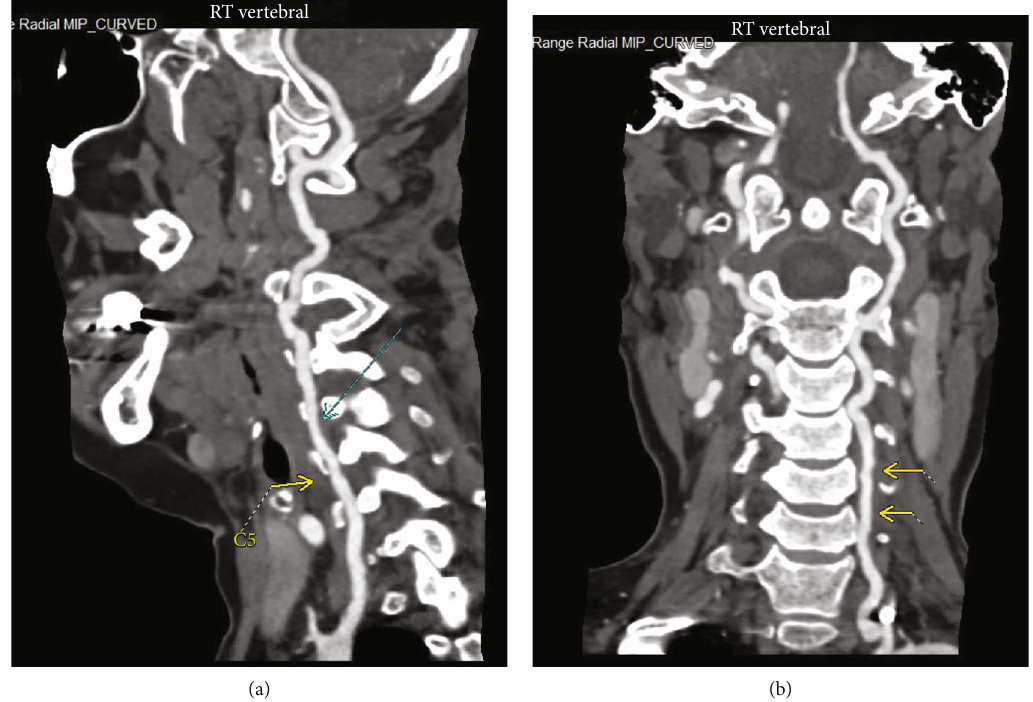
Figure 3: (a) Computed tomography angiography imaging showing the right vertebral dissection (cyan arrow). (b) Computed tomography angiography imaging showing the left vertebral artery dissection (yellow